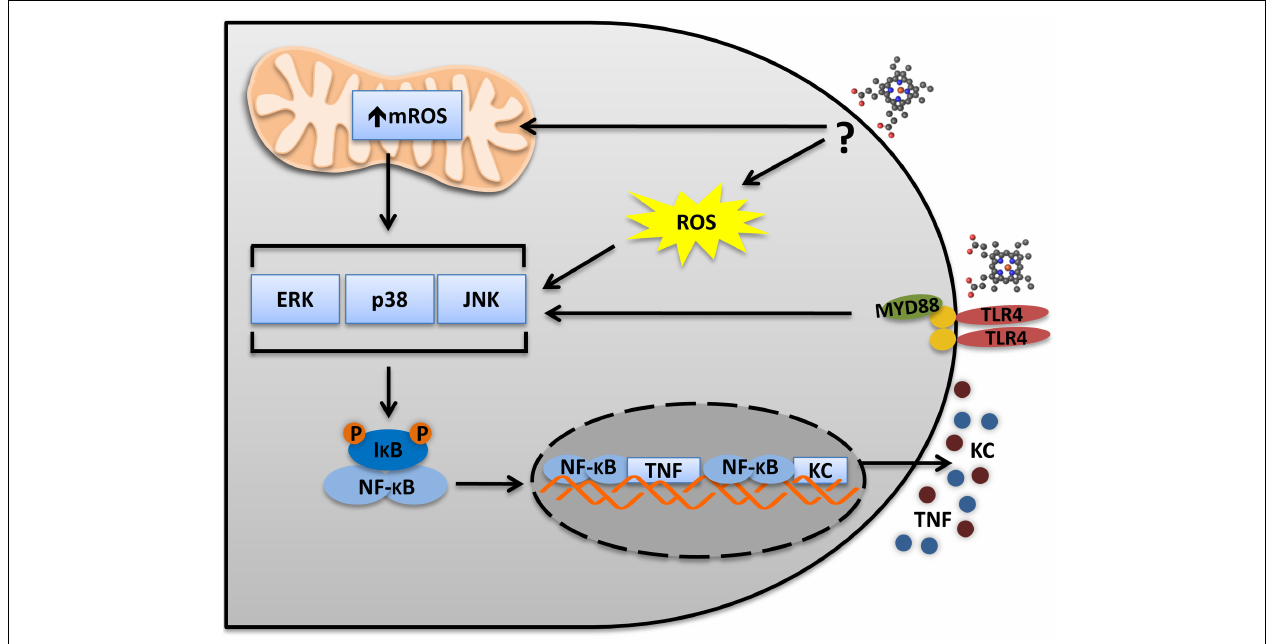
FIGURE 1 | Heme activates TLR4 in macrophages. The TLR4 activates two distinct pathways: MyD88 and TRIF. In macrophages, heme induces a biased MyD88 activation and the secretion of the pro-inflammatory cytokines TNF and KC. TLR4 activation leads to MAPKs and NF κ B activation, which are necessary to TNF secretion. Heme induces ROS generation independently of TLR4. However, ROS is necessary to induce TNF secretion and MAPK activation. Thus, TLR4